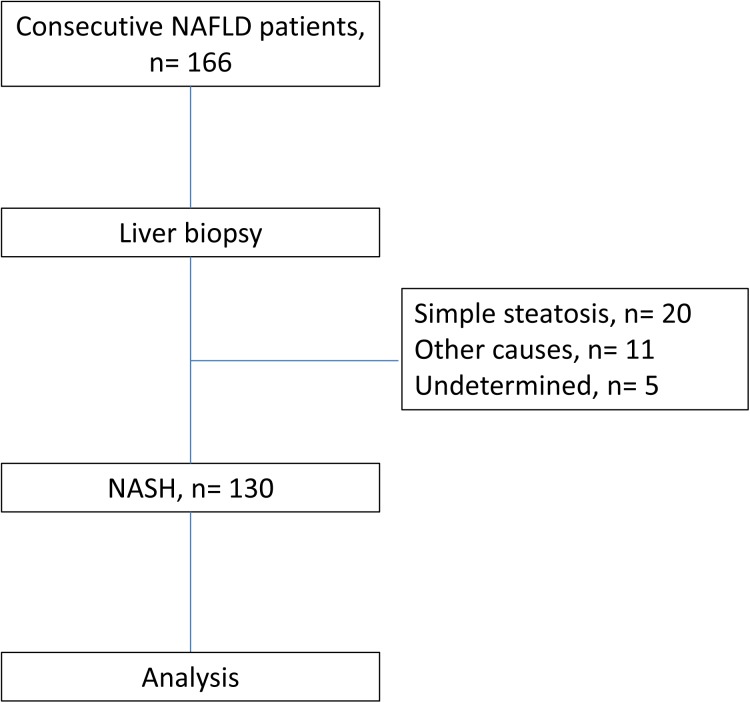
The flowchart of the study.